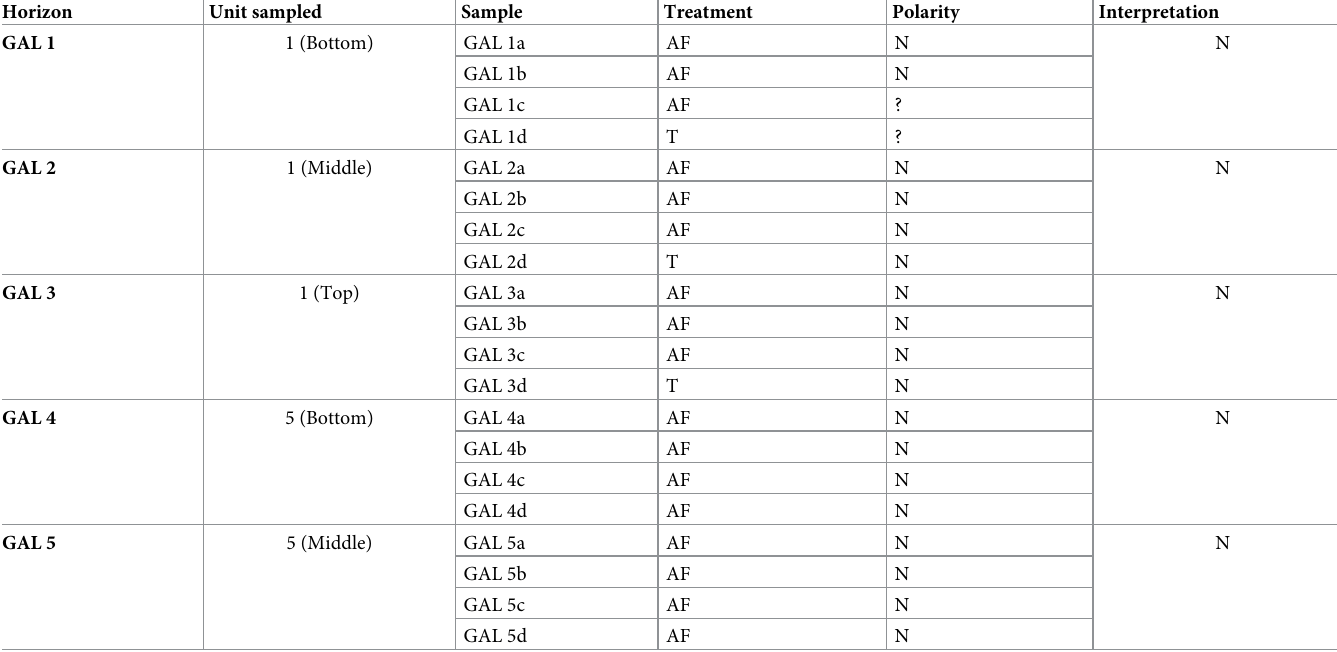
Finally, the westernmost Area E represented a somewhat unique phenomenon in com- parison to the other excavated localities. Here, Unit 4 was very thin (less than 10 cm), and the density of gravel very low, possibly indicating the margins of the fluvial environ in which Areas A-D and G were deposited. Artifacts were found in three main clusters, each of them ca. 0.5 m in diameter, embedded on top of the Hamra soil of Unit 1 (Fig 4D). While find density was extremely low in comparison to the other excavated areas, artifacts were found in an excellent state of preservation, implying they were not subjected to post deposi- tional movement. Table 4. Paleomagnetic interpretations of the samples from Jaljulia (Area B). Horizon Unit sampled Sample Treatment Polarity Interpretation GAL 1 1 (Bottom)